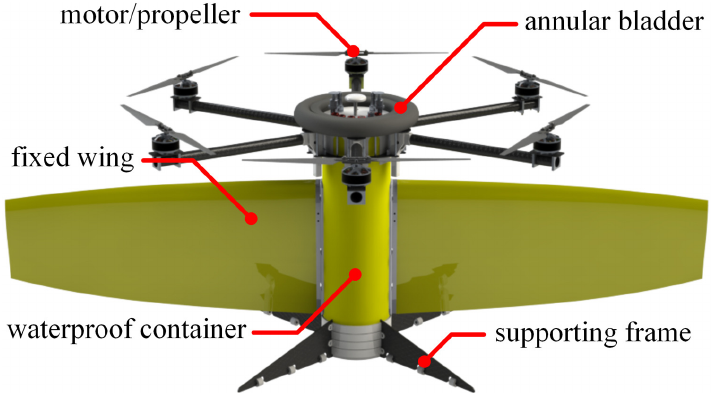
Figure 2. A 3D rendering of the proposed HAUV integrating the features of fixed-wing UAVs, rotary-wing UAVs, and UGs [8].